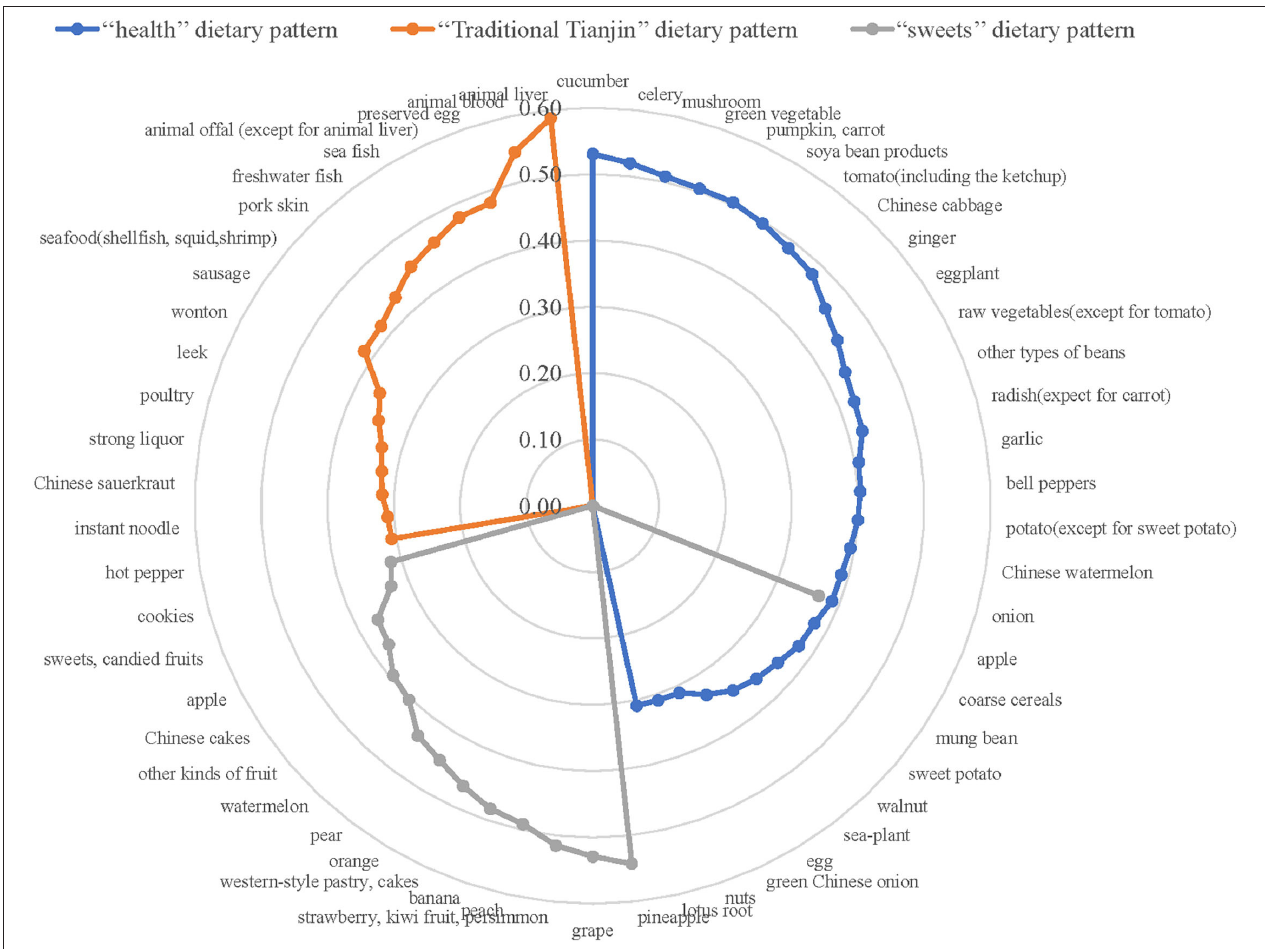
FIGURE 2 | Radar graph of factor loadings characterizing dietary patterns. The blue line indicates factor loadings related to the “health” dietary pattern. The orange line indicates factor loadings related to the “Traditional Tianjin” dietary pattern. The gray line indicates factor loadings related to the “sweets” dietary pattern. Dietary patterns are described based on factor loadings with absolute value ≥